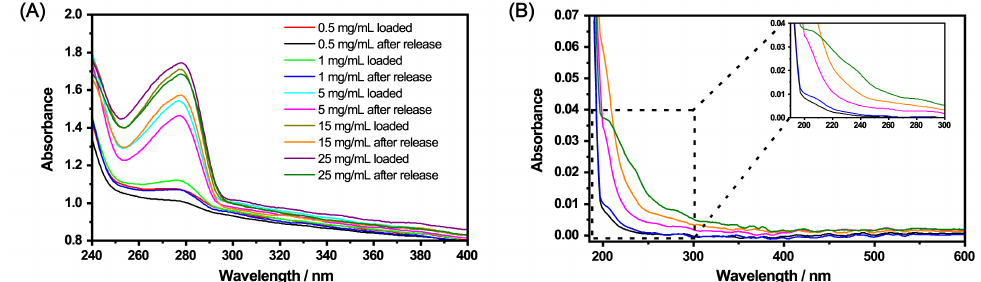
Figure 12. UV/Vis measurements of the copolymer microgels loaded with CBD and after the release of CBD ( A ). The loading was conducted in ethanol at 20°C, then the solvent was completely removed and replaced by water. CBD in the supernatant after the release (40°C) in water ( B ). The concentrations in ( B ) correspond to the colours after the release in ( A ).